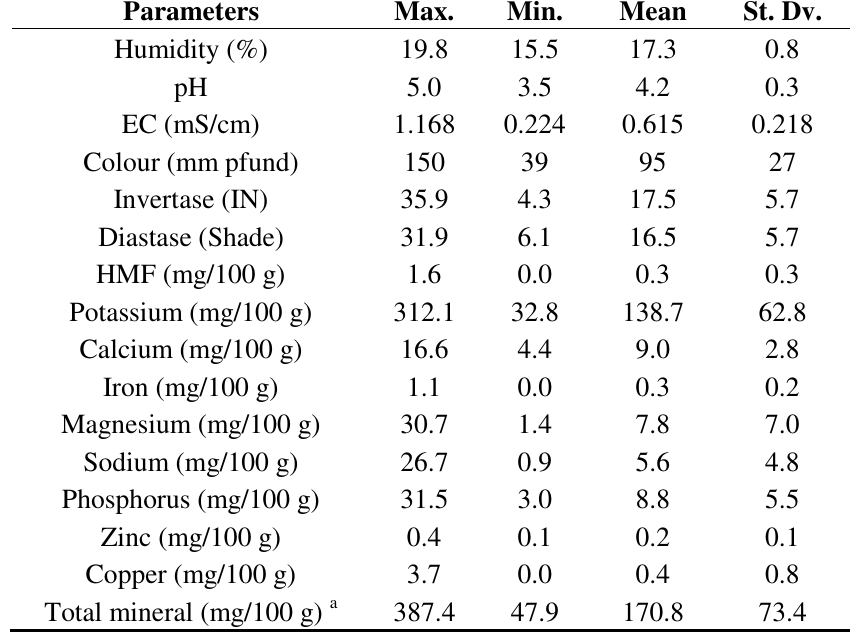
Table 3. Descriptive analysis of physicochemical